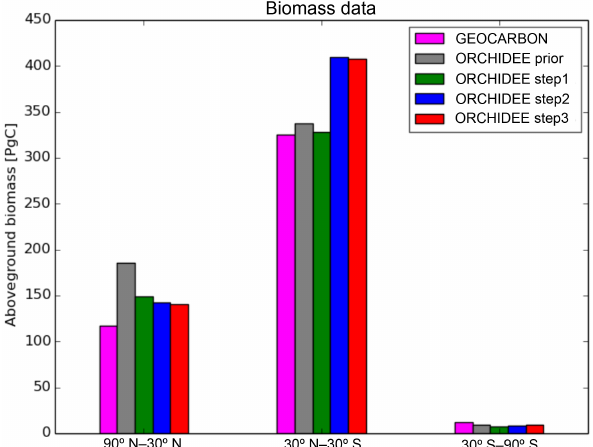
Figure 12. Aboveground forest biomass data for the prior OR- CHIDEE model and after step 1, step 2 and step 3 of the opti- mization process. Estimates from satellite observations (Santoro et al., 2015) and referred as “GEOCARBON” (following the EU- GEOCARBON project) are provided for